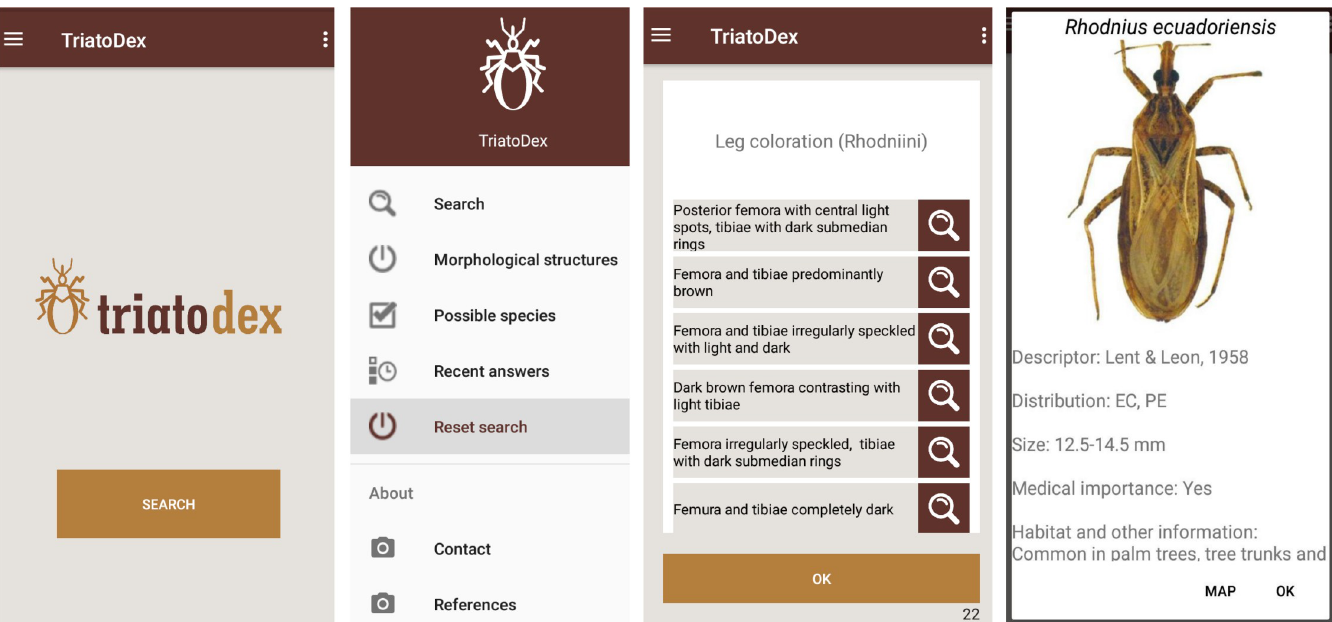
Fig 1. T RIATO D EX screens: Opening screen; main menu; example of questions and answers (note the magnifying-glass icons, which link to detail images of each structure); and example of last step with a picture of an adult specimen (here, Rhodnius ecuadoriensis ) and taxonomic, distributional (note the link to the map), morphological, and ecological